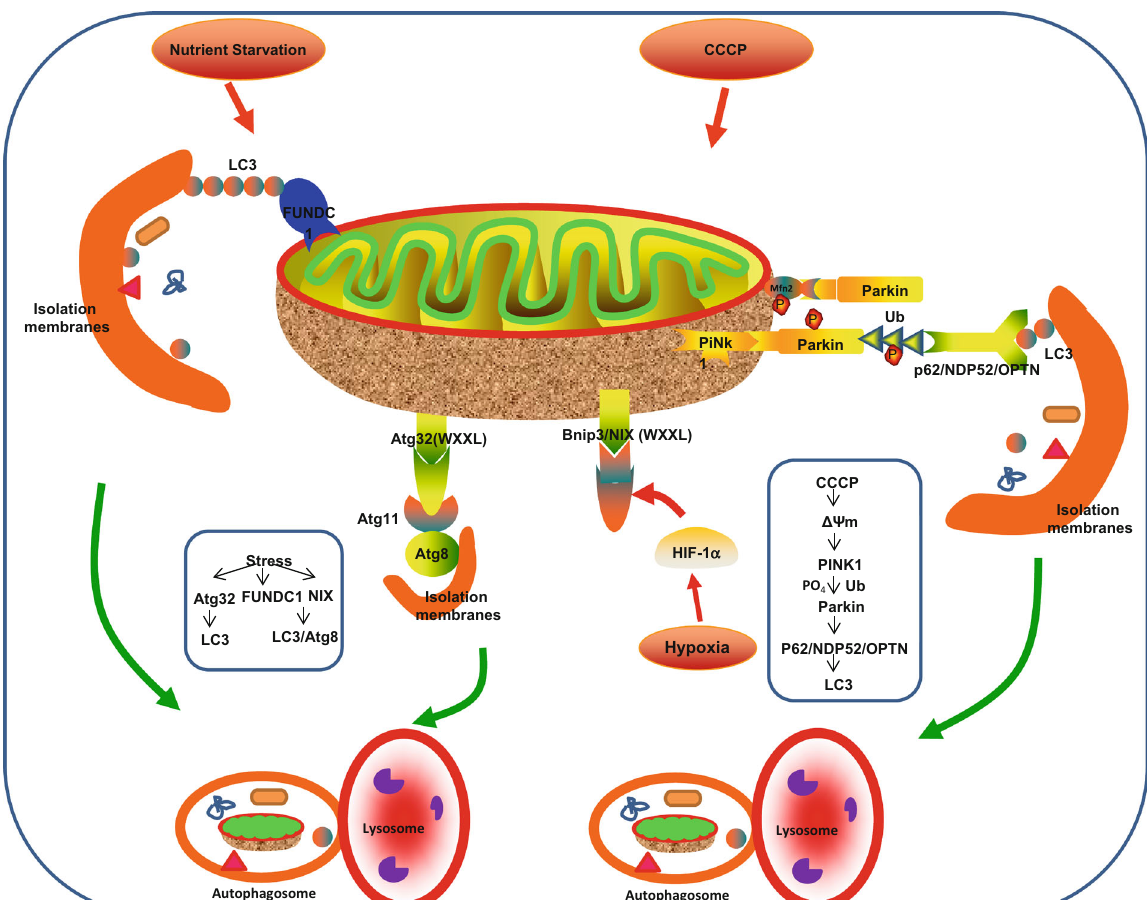
Figure 2. Mechanisms of mitophagy. (a) In yeast, the outer mitochondrial membrane protein Autophagy-related 32 (Atg32) binds the isolation membrane protein Atg8 through its WXXL-like motif. This process requires adaptor protein Atg11, which can form a complex with Atg32 and Atg8 and physically link mitochondria with isolated membranes. Finally, the mitochondria are sealed by the isolation membranes and fuse with lysosome to be degraded. Uth1p and Aup1p are both mitochondria membrane proteins and can facilitate mitophagy under certain special conditions, such as starvation. (b) In mammalian cells, (1) Parkin-dependent pathway. After treatment with CCCP or other mitochondria inhibitors, the mitochondria are damaged and lose membrane potential, which can lead to impaired PINK1 cleavage and stabilization. At that point, PINK1 phosphorylates Parkin and ubiquitin at Ser65 to recruit Parkin to damaged mitochondria from the cytosol. Parkin ubiquitylates the mitochondrial substrates and generates more ubiquitin substrate for PINK1 to phosphorylate; then, the ubiquitin-binding adaptor p62/NDP52/OPTN aggregates ubiquitylated proteins and recruits ubiquitylated cargo into autophagosome by binding to LC3. Finally, the mitochondria are sealed by the isolation membranes and fuse with lysosomes to be degraded. (2) Parkin-independent pathway. The most important Parkin-independent pathway is the